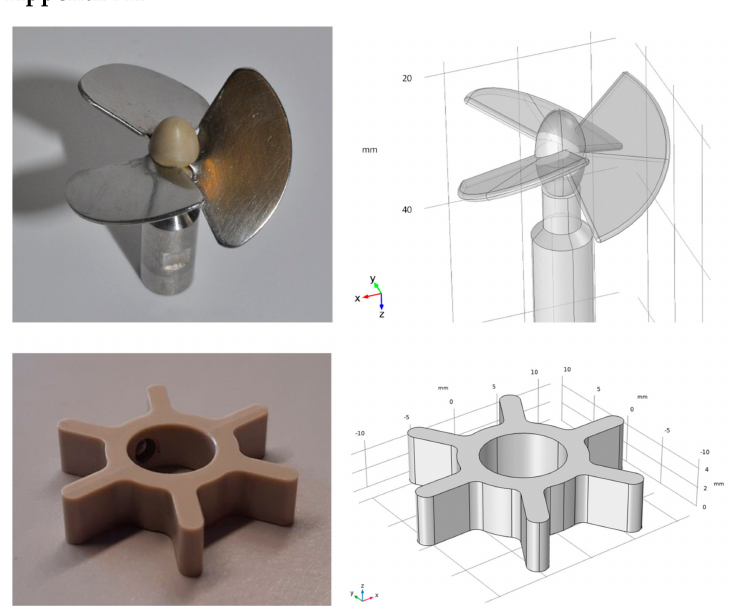
Figure A1. Pitched blade impeller ( above ) and six blade impeller ( below ) with corresponding CAD models. For the pitched blade impeller, a Newton number Ne of 0.35 was determined with an empiric correlation [7], while for the six blade impeller, 3.95 was considered, following another empiric correlation